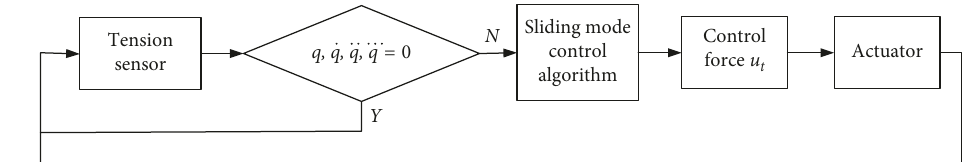
Figure 2: The schematic diagram of sliding mode